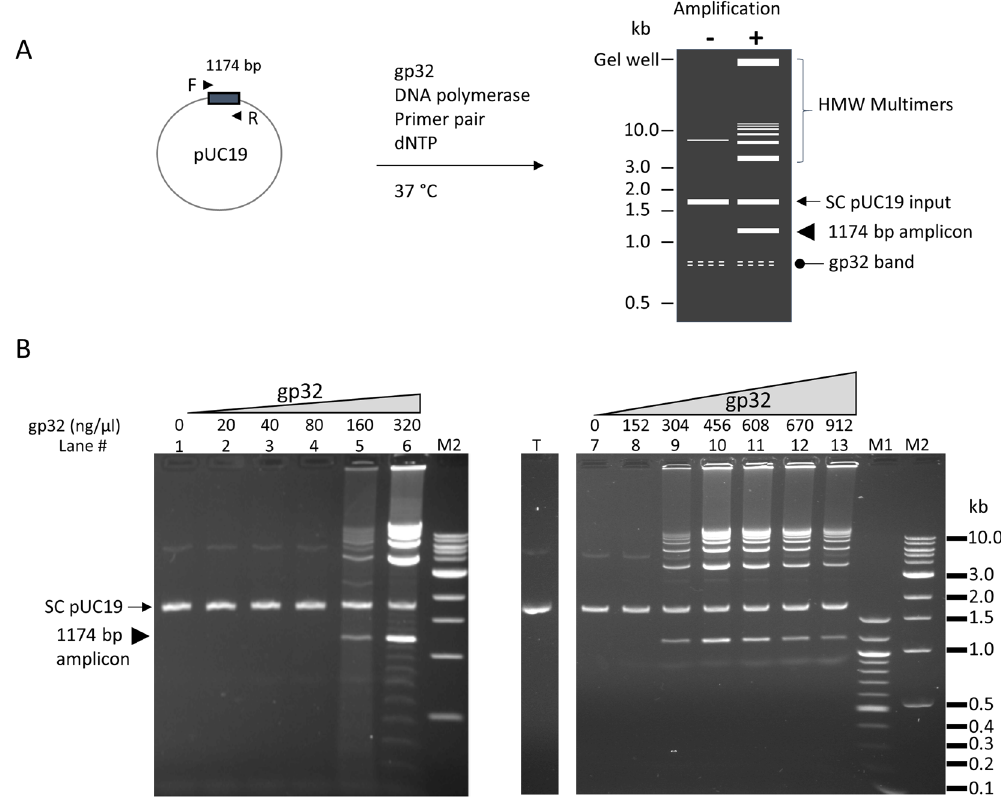
Figure 1. T4 gp32 protein-assisted isothermal amplification on circular dsDNA template pUC19. ( A ) schematic representation of the amplification reaction and product pattern after agarose gel electrophoresis. Primer pair consisting of the F and R primers (arrow heads) allows the amplification of a 1174 bp amplicon (box) of the pUC19 plasmid (circle). When there is no amplification, pUC19 migrates as a supercoiled band (SC pUC19, arrow) and weaker upper band. There is usually a faint and often diffuse band migrating at approximately 0.8 kb (oval arrow) whenever gp32 protein is present in the reaction. The amplification products consist of a band of the single amplicon (arrow head), high molecular weight (HMW) multimers (bracket) including those forming a ladder pattern and those retained in the gel well. HMW multimers migrate slower than the SC pUC19 input (arrow) and the linearized pUC19 (not shown). ( B ) Effect of gp32 concentration on the amplification of 0.1 μ g of pUC19 template using primer #21: Left panel (lanes 1–6), low range of gp32 (20–320 ng/ μ l); Right panel (lanes 7–13), high range of gp32 (152–912 ng/ μ l). Lanes 1 and 7 contained no gp32 as negative controls. The location of the single amplicon (1174 bp) flanked by primer pair #21 is marked by an arrow head in the left panel. Lane T has 0.1 μ g pUC19 alone without any treatment. M1 and M2 are 100 bp ladder and 1 kb ladder DNA markers